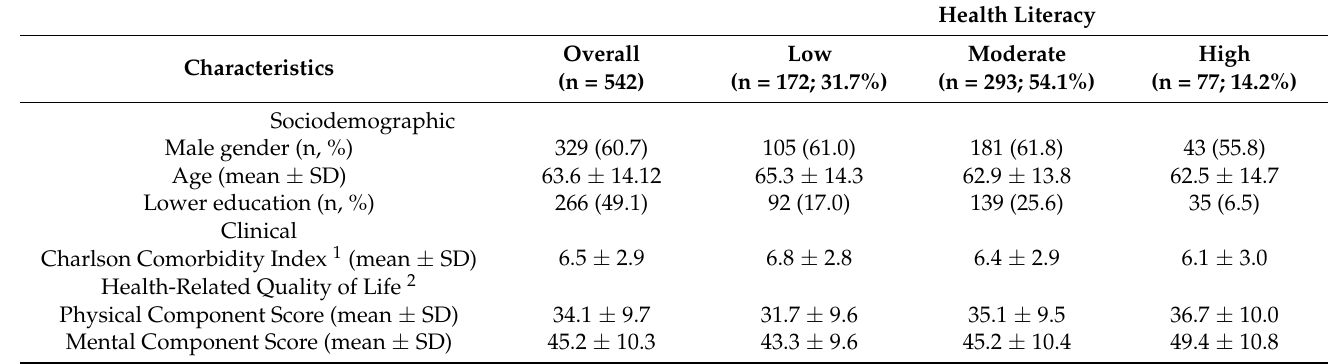
Table 1. Characteristics of the sample: gender, age, education, CCI, PCS, and MCS, overall and by 3 HL groups, frequencies or means (n = 542, patients from 20 dialysis clinics in Slovakia interviewed in 2018).